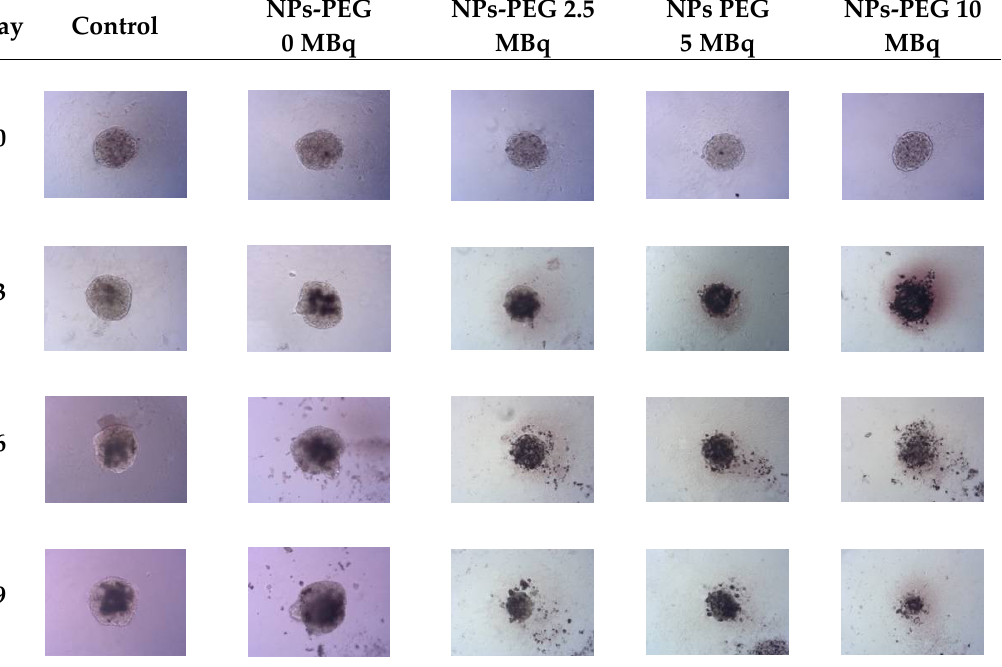
Figure 9. Microscope images of representative spheroids. Images made for spheroids incubated for 1 h with radioactive NPs-Tmab on the day of treatment (Day 0) and on Days 3, 6, and 9 after treat- ment. Images were acquired with Primovert microscope equipped with Axiocam 105 color (Zeiss, Jena, Germany) with ZEN 2.3 lite software (Zeiss, Jena, Germany), 5× magnification.